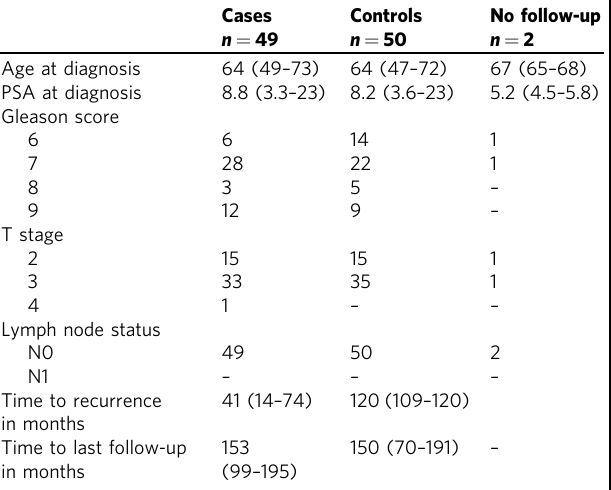
Fig. 1 Overview of data. a Illustration of the matched case-control cohort. Prostate tumor samples from 49 patients with biochemical recurrence were matched to 50 patients without a recurrence. Samples were matched on clinical parameters age, TNM stage, PSA level, and Gleason score. Fresh frozen material of each patient was processed for RNA-seq, AR ChIP-seq, H3K27ac ChIP-seq, H3K4me3 ChIP-seq, and H3K27me3 ChIP-seq. The male silhouette was adapted from Wikipedia (https://upload.wikimedia.org/wikipedia/commons/archive/4/4e/20180727161732%21Aiga_toiletsq_men.svg). b Data availability for RNA-seq, AR ChIP-seq, H3K27ac ChIP-seq, H3K4me3 ChIP-seq, and H3K27me3 ChIP-seq for each sample. Columns represent individual patient samples. Cases and controls are depicted in red and blue, respectively. Two samples without follow-up are depicted in green (top row) Table 1 Characteristics of the Porto cohort ( n =